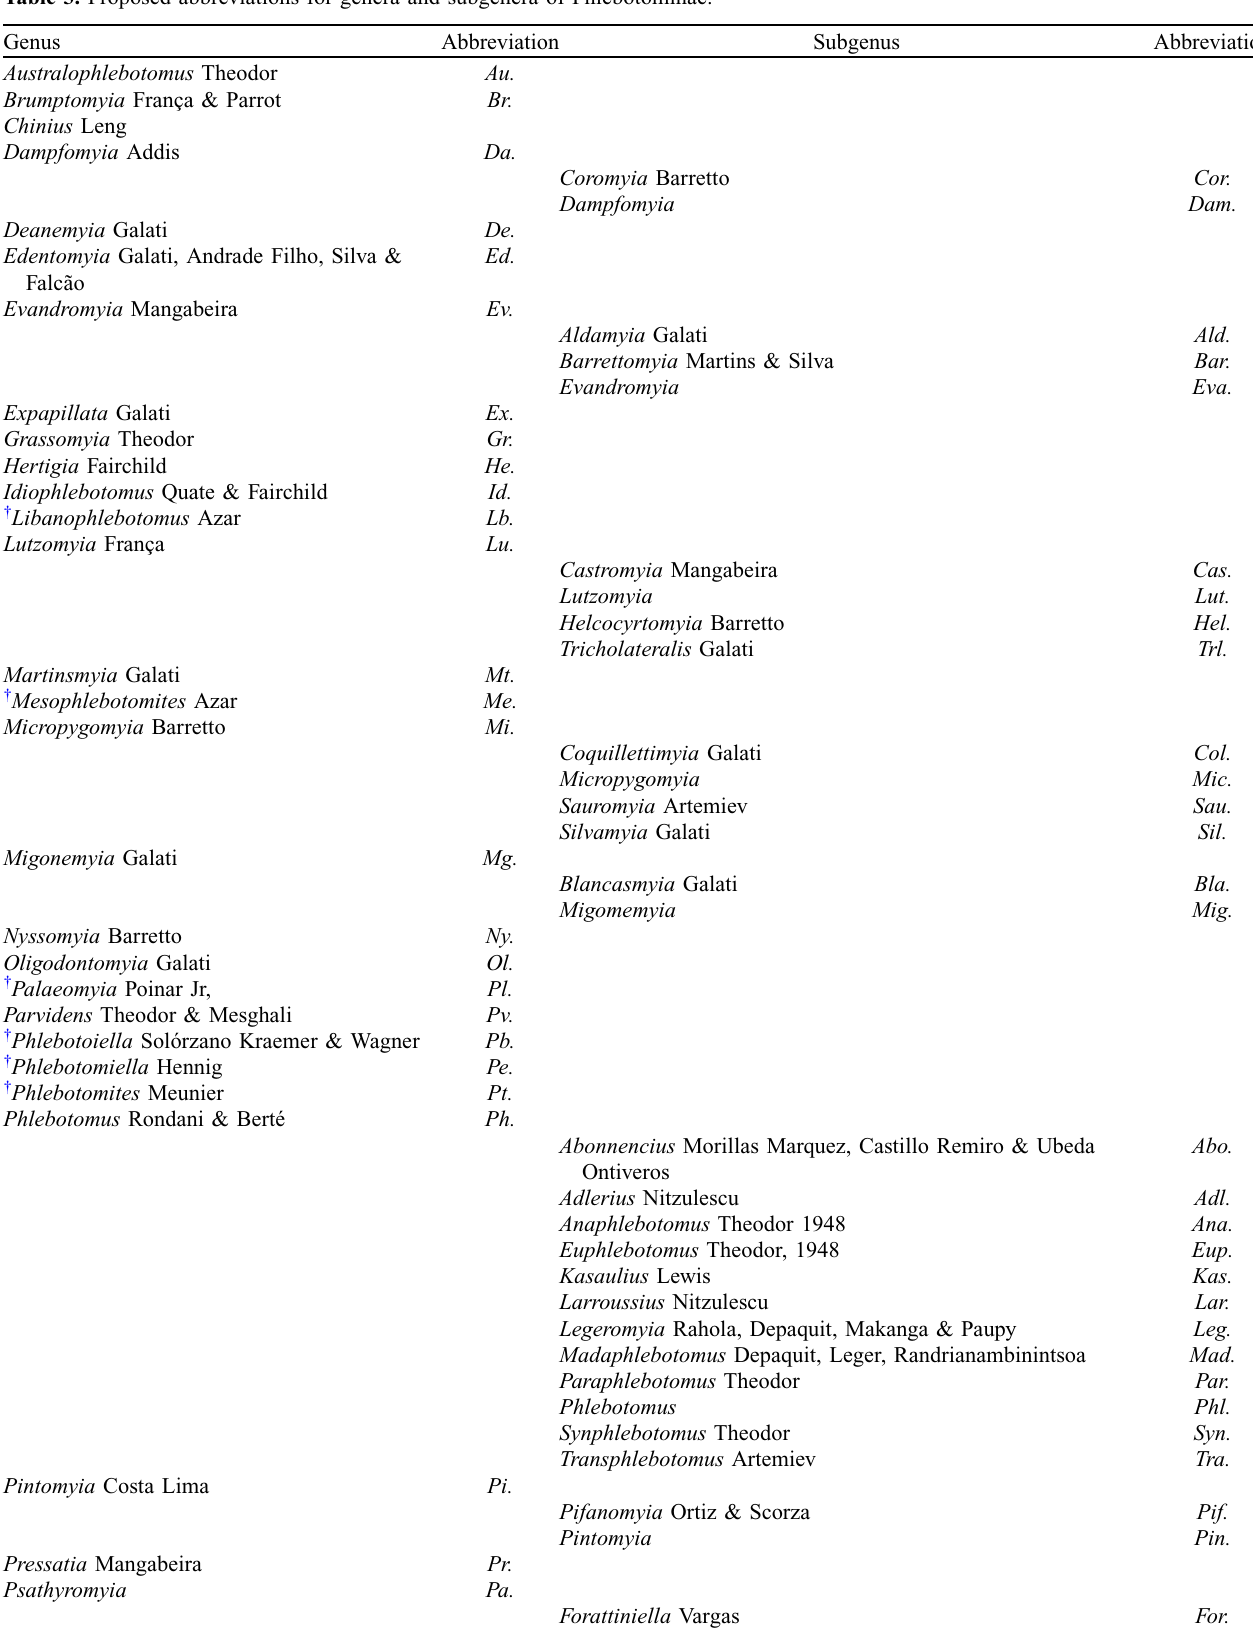
Table 3. Proposed abbreviations for genera and subgenera of Phlebotominae.